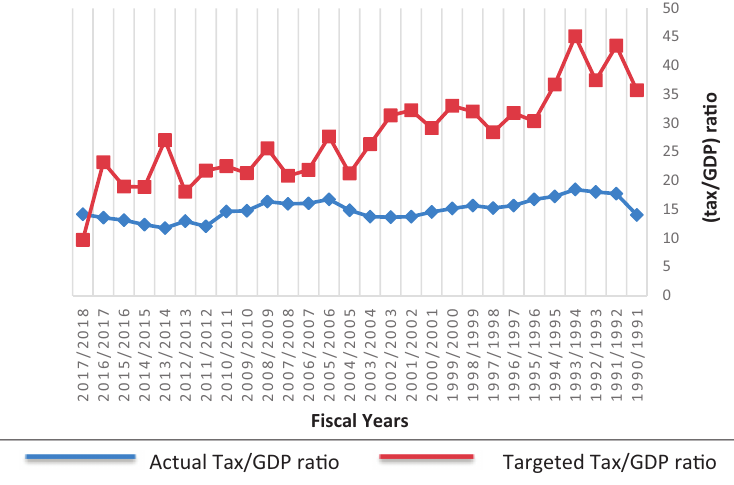
Figure 2. Evolution of tax gap indicator in Egypt during FY 1990/1991